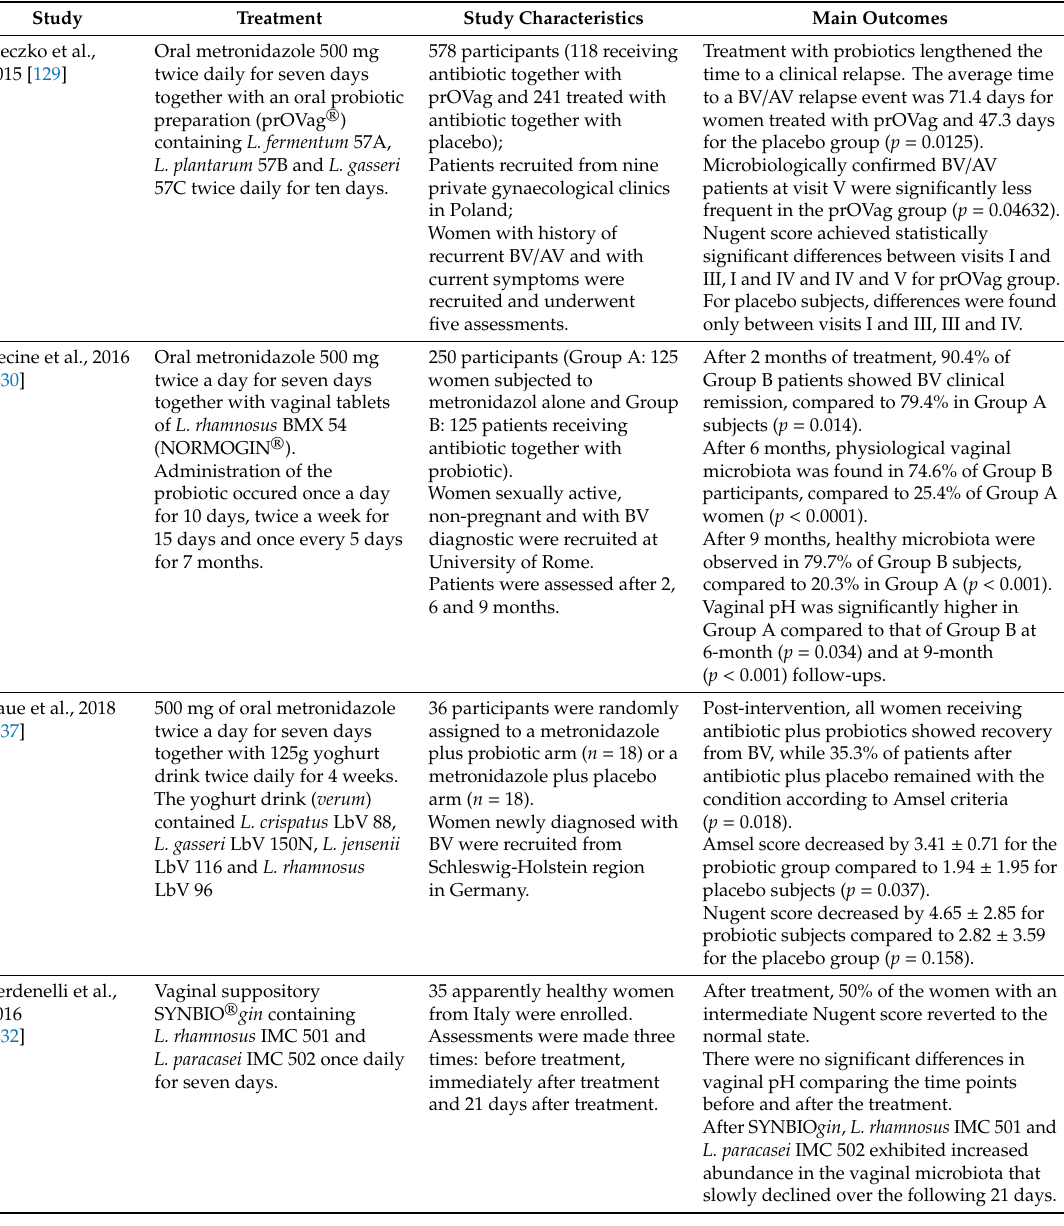
Table 1. Highlights of clinical trials that explored the use of probiotics to bacterial vaginosis treatment, HPV infection and abnormal cervical cytology. BV, bacterial vaginosis; AV, aerobic vaginitis; VVC, vulvovaginal